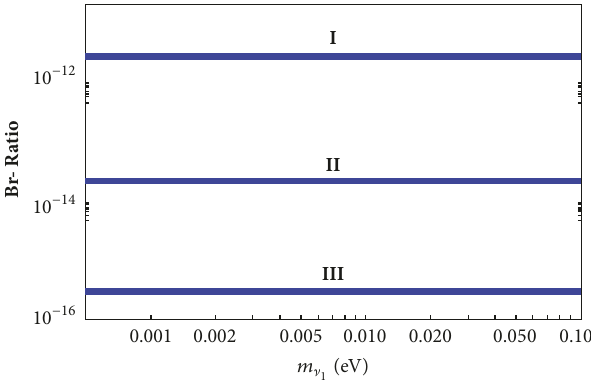
Figure 2: Variation of LFV decay branching ratios as a function of the lightest neutrino mass. Colored horizontal lines represent I : 𝐵𝑅(𝜏 󳨀→ 𝜇𝛾) , II : 𝐵𝑅(𝜏 󳨀→ 𝑒𝛾) , and III : 𝐵𝑅(𝜇 󳨀→ 𝑒𝛾)